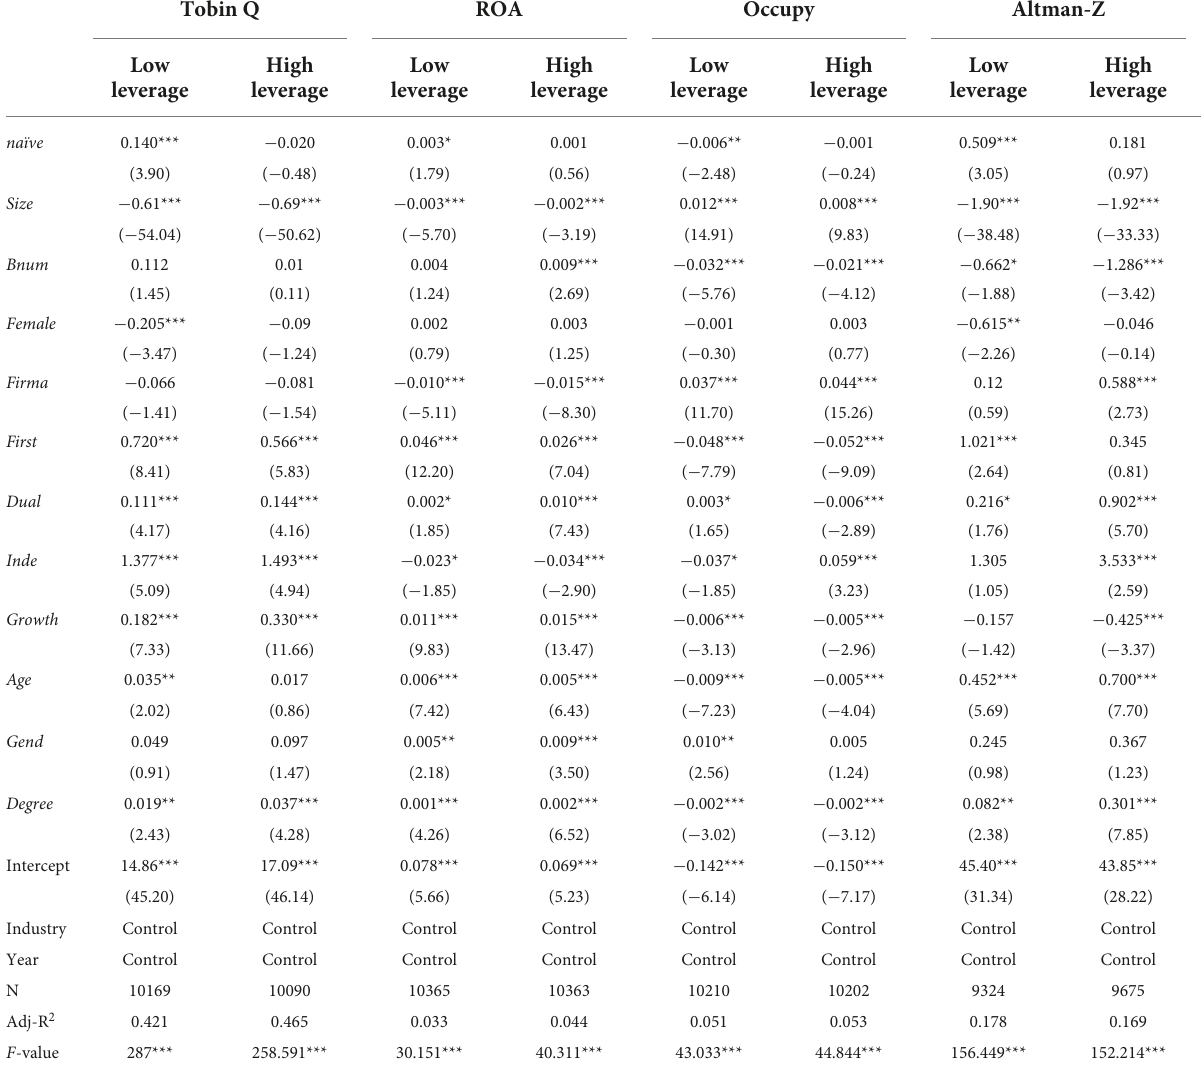
TABLE 10 The effects of financial